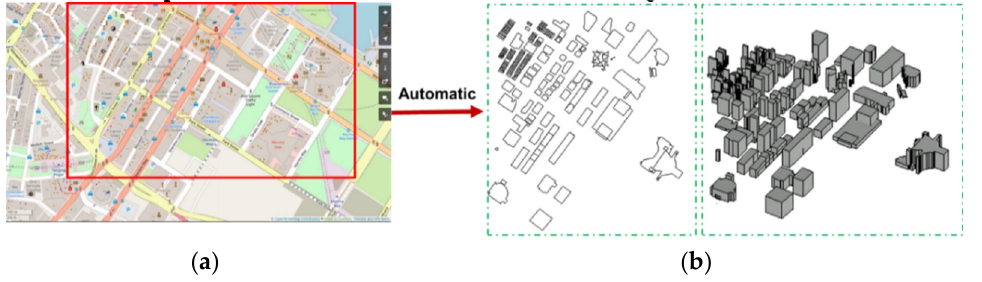
Figure 11. Location and generated model of the basic study area. ( a ) Site plan, ( b ) Generated BIM scenarios.